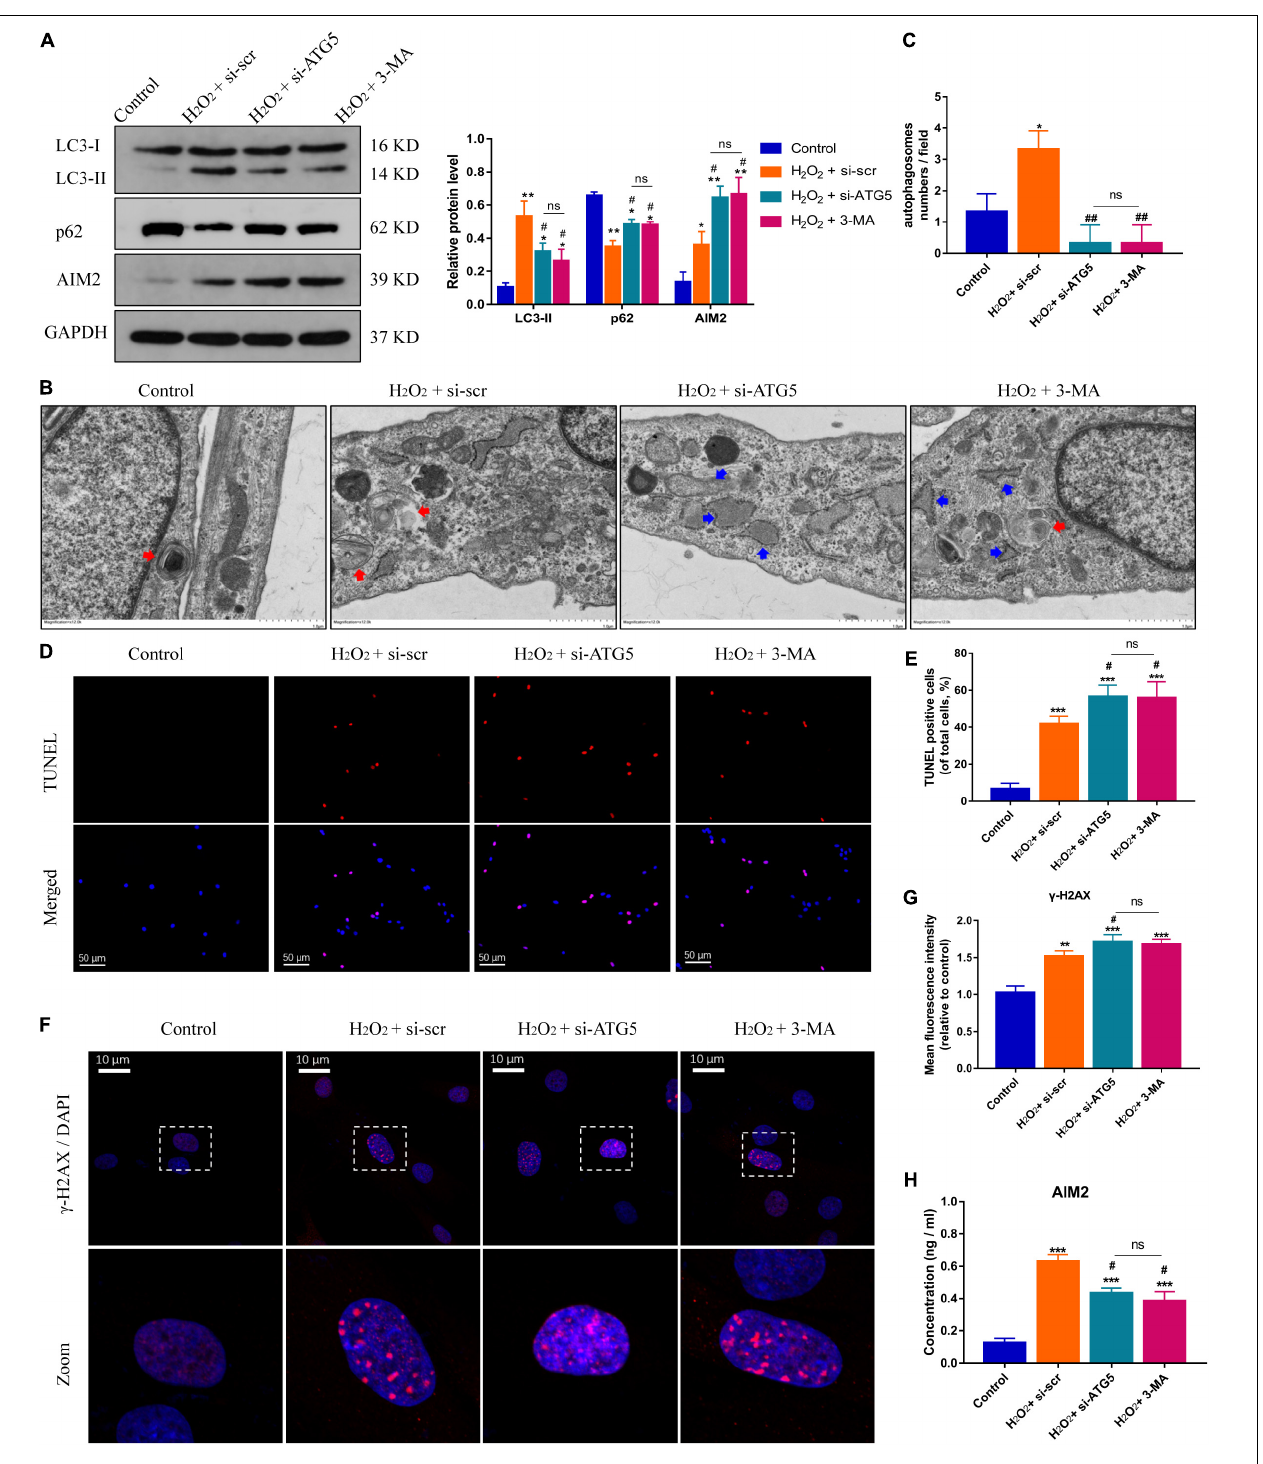
FIGURE 4 | Inhibition of autophagy aggravates DNA damage and NP cell apoptosis, and decreases AIM2 secretion. (A) Protein levels and quantification of AIM2, LC3, and p62 in H 2 O 2 -treated NP cells co-treated with si-scr, si-ATG5, or 3-MA (20 mM, 8 h). (B,C) TEM images of NP cells indicated the number of autophagosomes (red arrows) and irregular intracellular vesicles (blue arrows), and quantification of autophagosomes numbers (C) . (D,E) TUNEL images of NP cells in different groups (D) and corresponding quantification of cell apoptosis (E) . (F,G) Immunostaining of γ -H2AX (F) and mean fluorescence intensity of NP cells in different groups (G) . (H) Extracellular levels of AIM2 measured by ELISA analysis. Data were presented as the means ± SD, n = 3. * P < 0.05, ** P < 0.01, *** P < 0.001 vs. control group; # P < 0.05, ## P < 0.01 vs. H 2 O 2 -si-scr group; ns, P > 0.05, no significant difference.